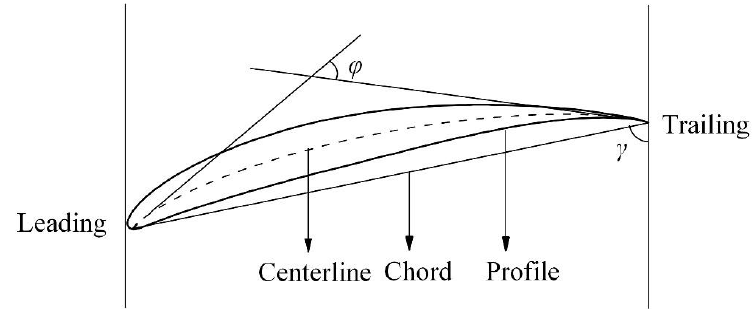
Figure 6. Foil shape parameters.